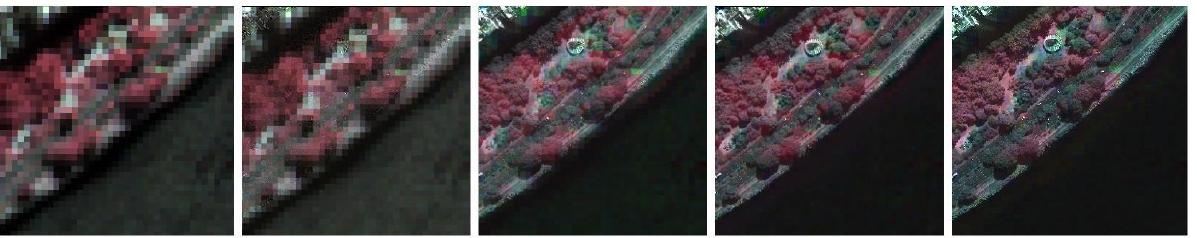
Figure 5. Results of the fusion experiment on an area of building. From left to right: Original SWIR images; ATWT; HIS; PCA and the proposed method.